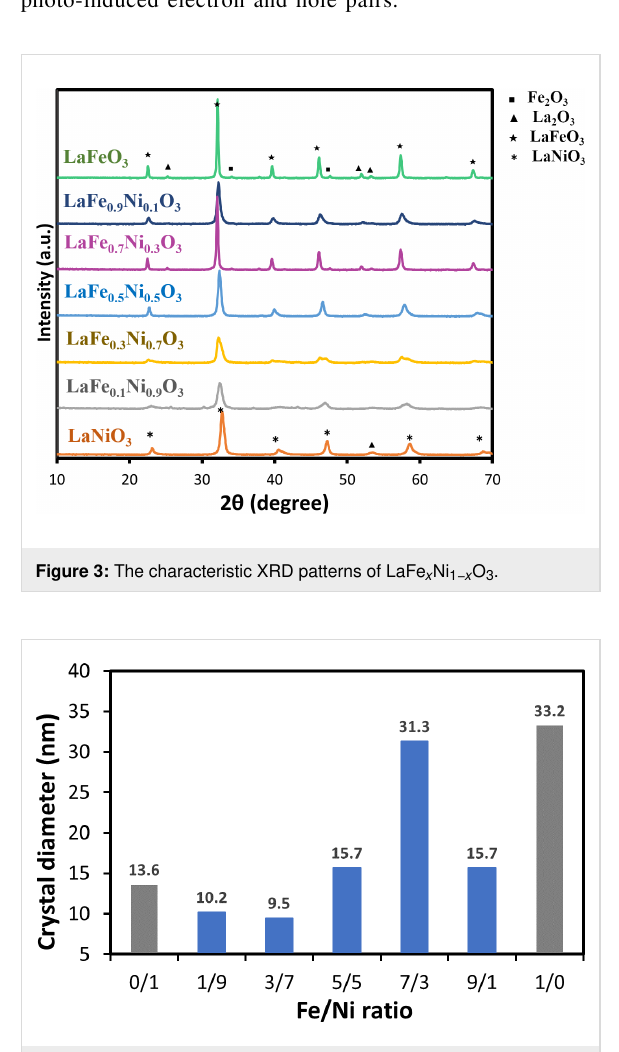
Figure 4: The crystal diameters of samples with various Fe/Ni doping ratios.